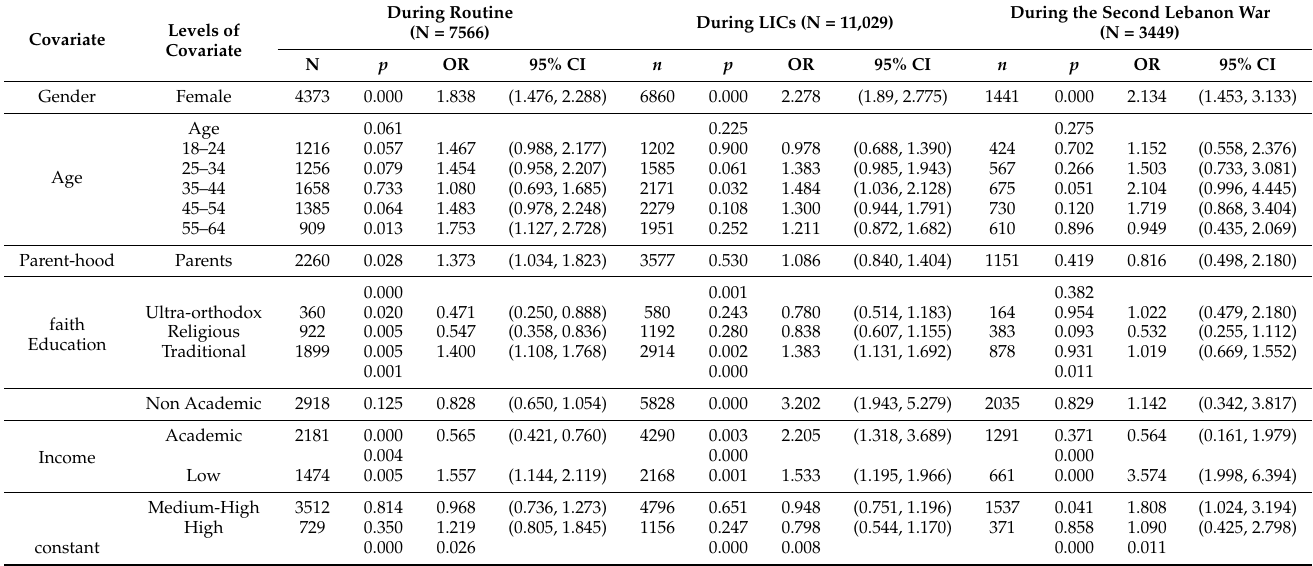
Table 4. Binary logistic model predicting the belonging to “Fearful” group during LICs and during routine, stratified